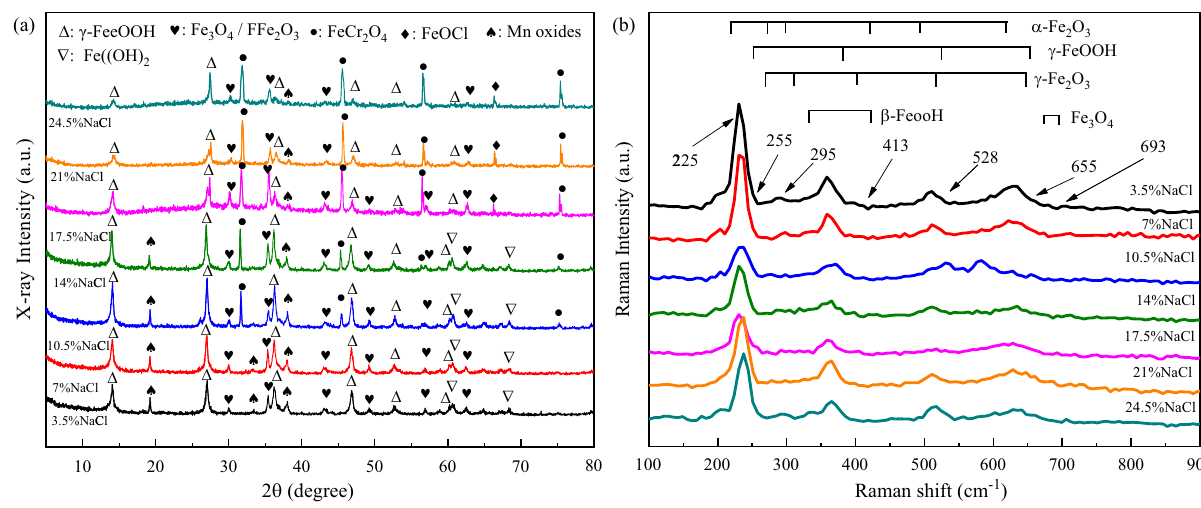
Figure 9: Corrosion products of samples exposed to di ff erent concentrations of NaCl solution for 600 h: ( a ) XRD di ff raction pattern and ( b ) Raman